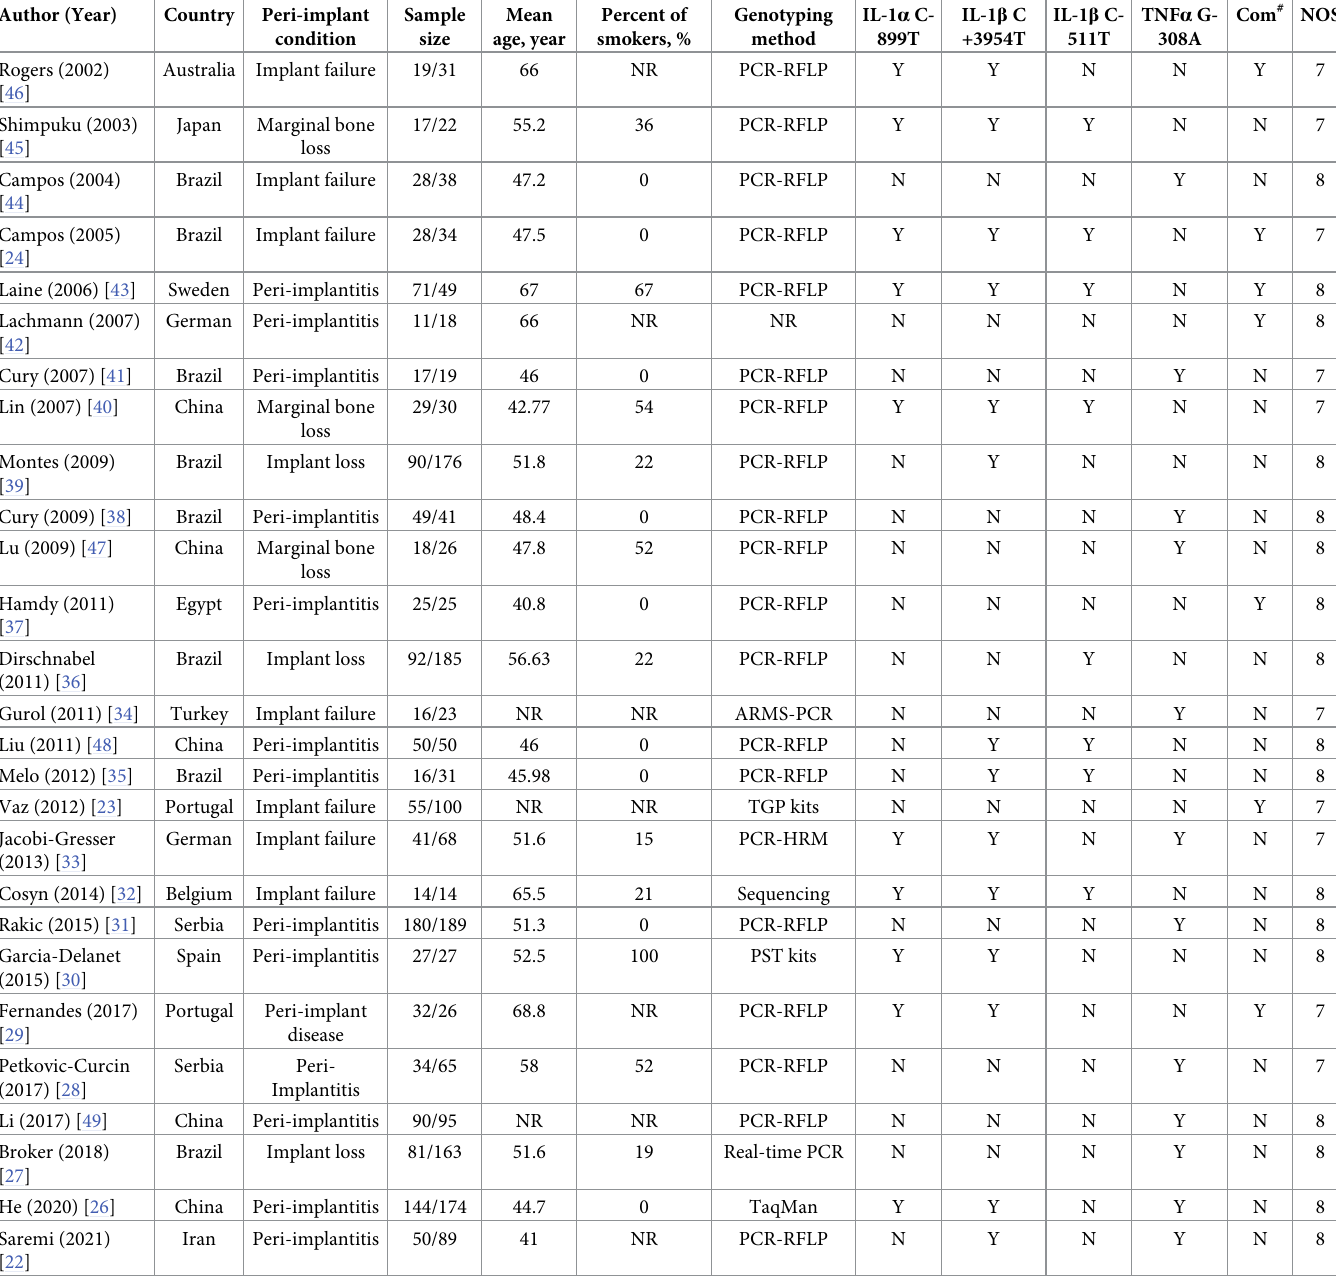
Table 1. Characteristics of all studies included in the meta-analysis. Author